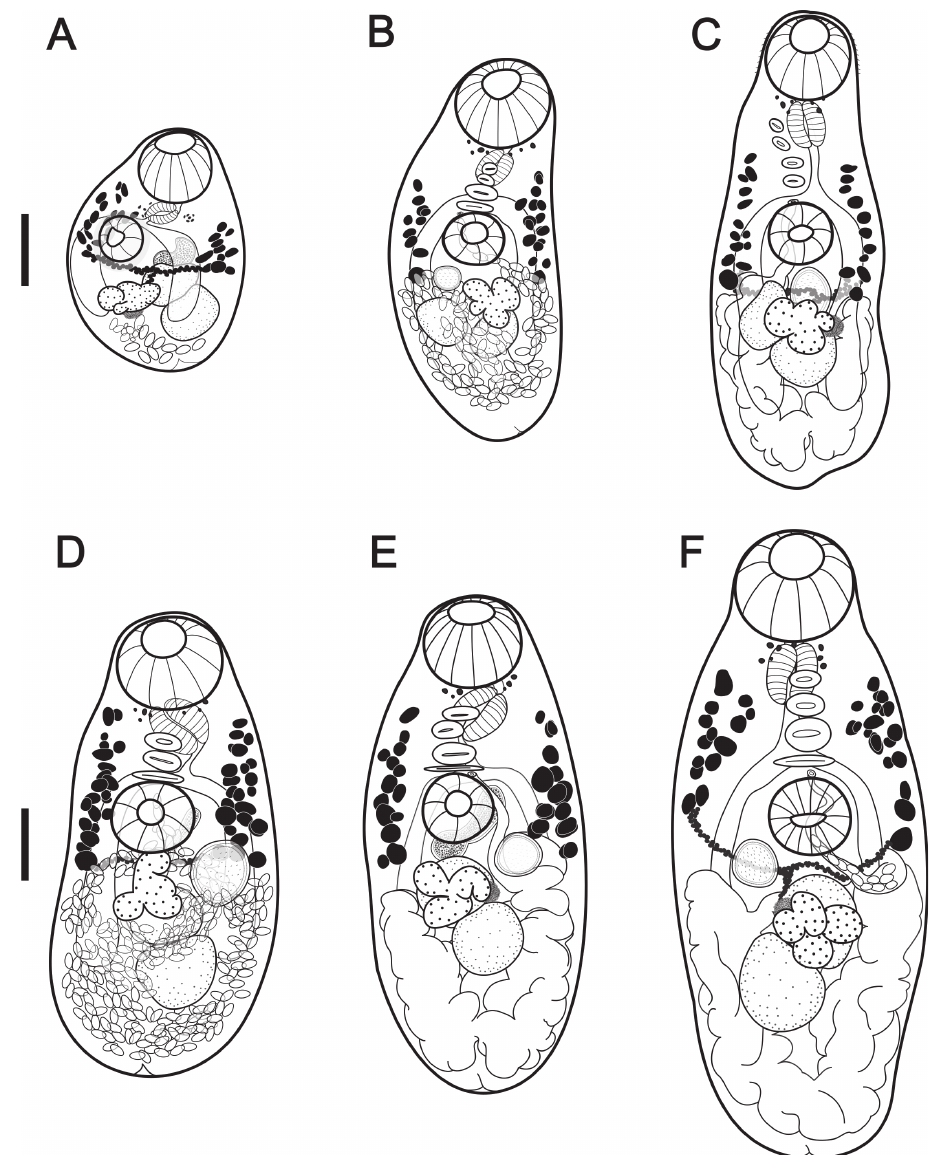
Figure 4. Paratypes of Oligogonotylus andinus sp. nov.; adults at different degrees of maturity A specimen in partly lateral orientation with the first eggs in utero; gonotyls were not observed B, D–F specimens with the seminal receptacle visible (left on B and F , right on E and D ) and four gonotyls A, C, D, F speci- mens with the vitelline duct visible A, D, E specimens with the seminal vesicle dorsal to the ventral sucker. Scale bars: 100 µm ( A–F